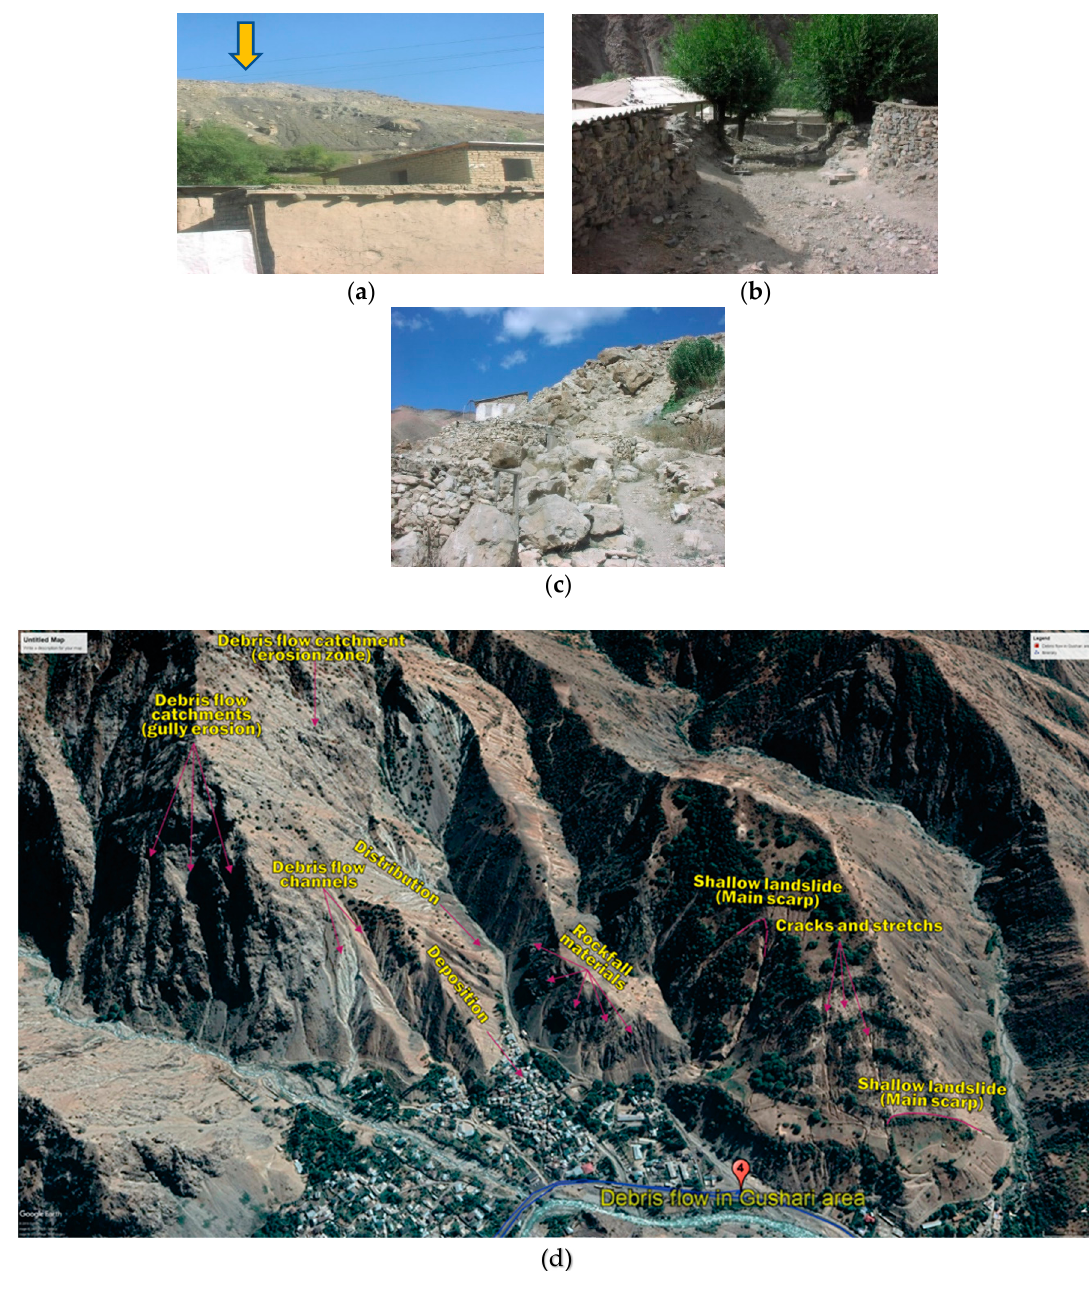
Figure 6. Illustration of landslides revealed by field survey and using Google Earth: shallow landslide laid up above houses ( a ), debris flow channel passes through people houses ( b ), rockfall near settlements ( c ), debris flow channels, shallow landslides, rockfalls were defined by Google Earth in Gushari area, study zone 4 ( d ).